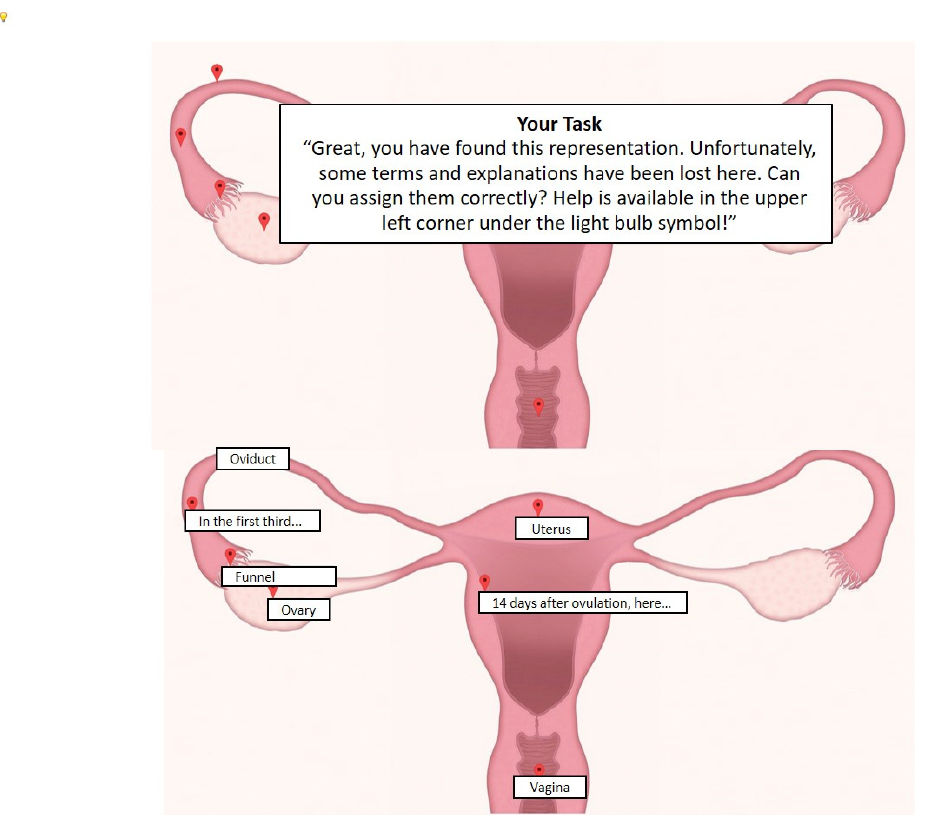
Figure 2. Labelling of segments of the uterus.